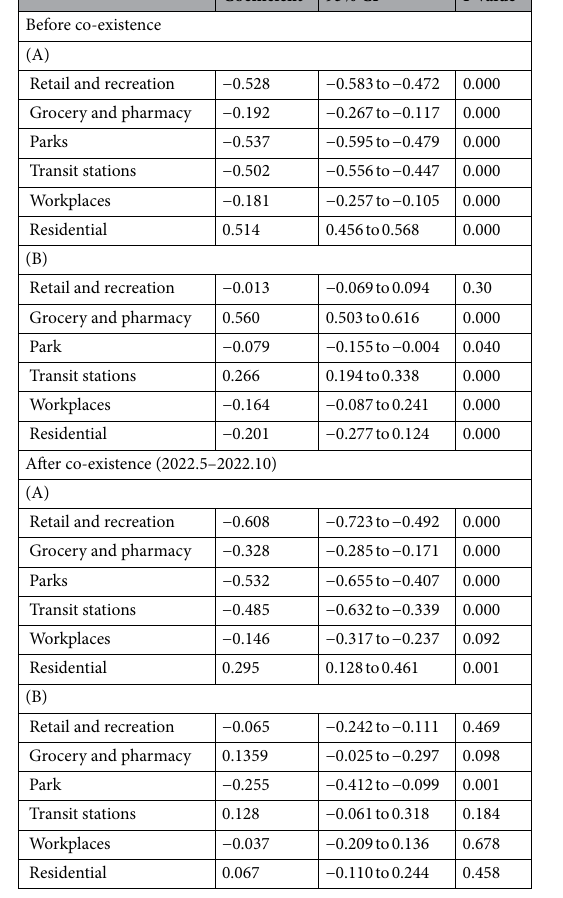
Table 1. Relationships of changes in population mobility at various locations with daily number of new confirmed cases per million people (7-day rolling average) (A) and reproduction rate (7-day rolling average) (B)